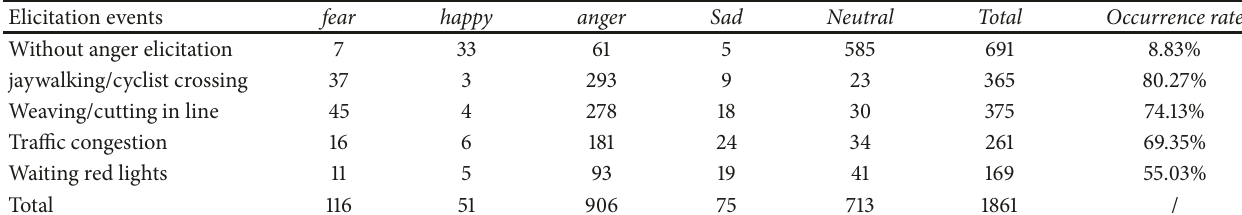
Table 2: Occurrence rate of five emotions from the scenarios with and without anger elicitation events.